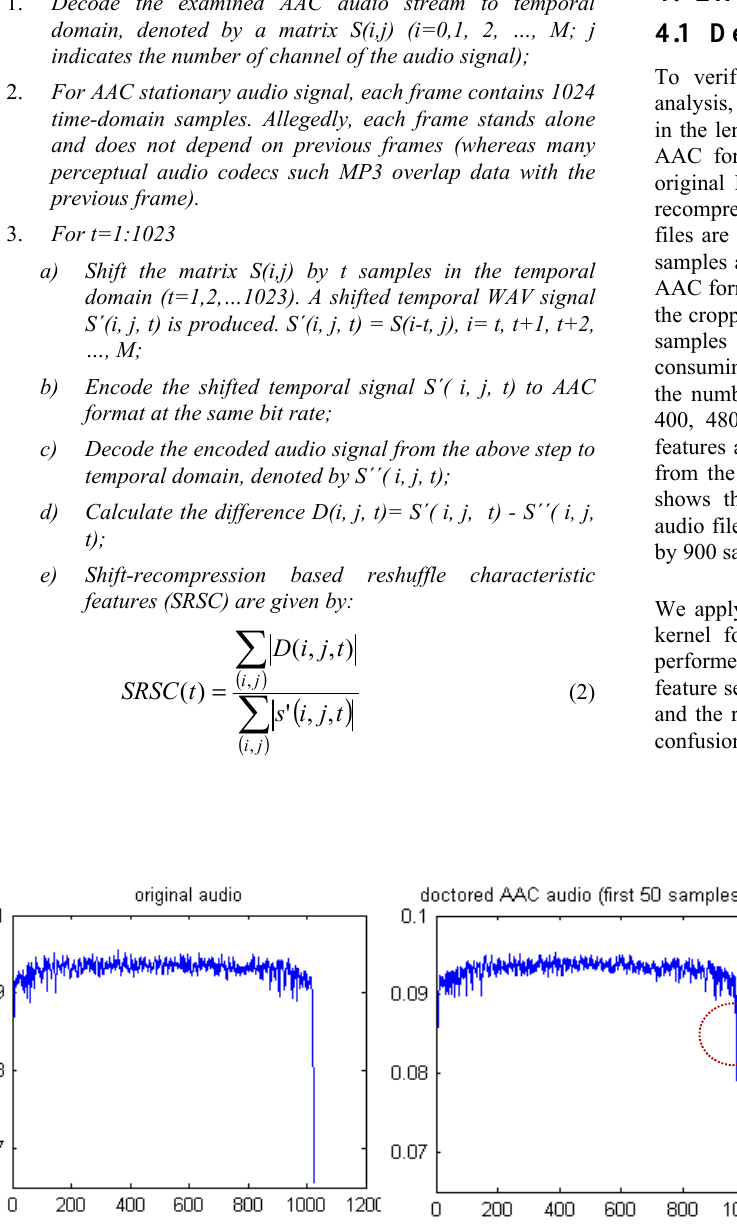
Figure 3. SRSC features of original AAC audio (a) and the AAC audio once cropped by 50 samples (b) and by 900 samples